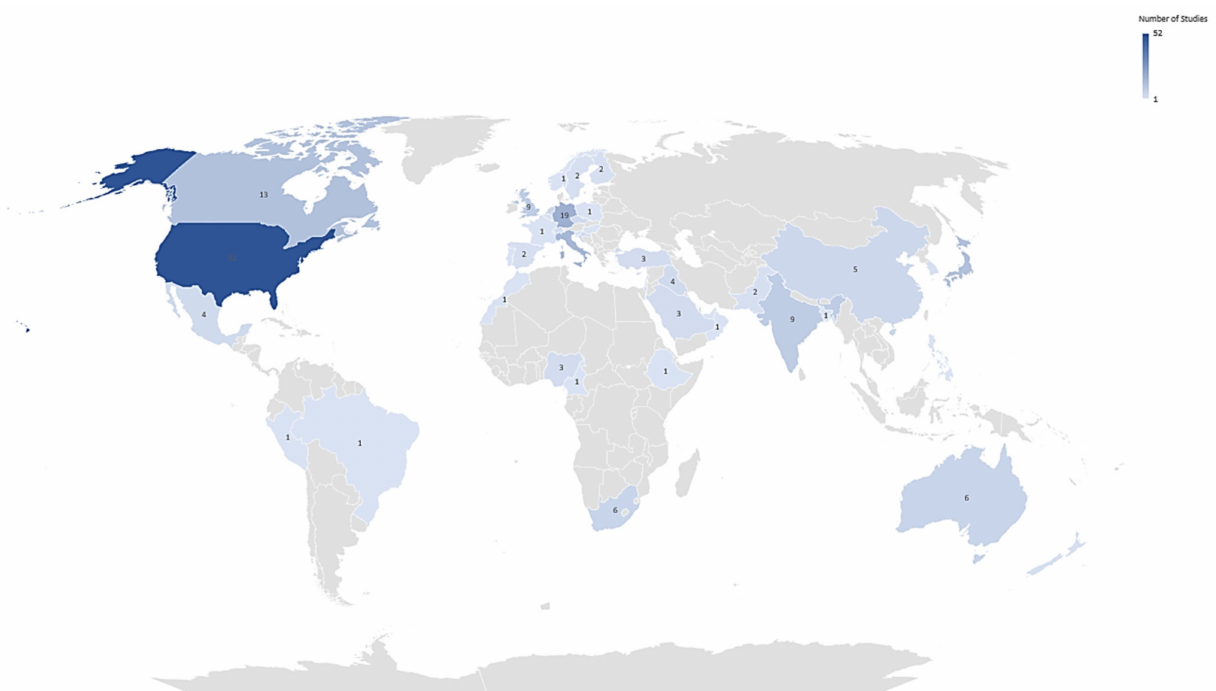
Figure 2. Map displaying the global distribution of all studies reporting the presence of one or more opportunistic premise plumbing pathogens in residential properties. Number of studies conducted in each country is indicated by colour intensity. Colour intensity increases as the number of studies